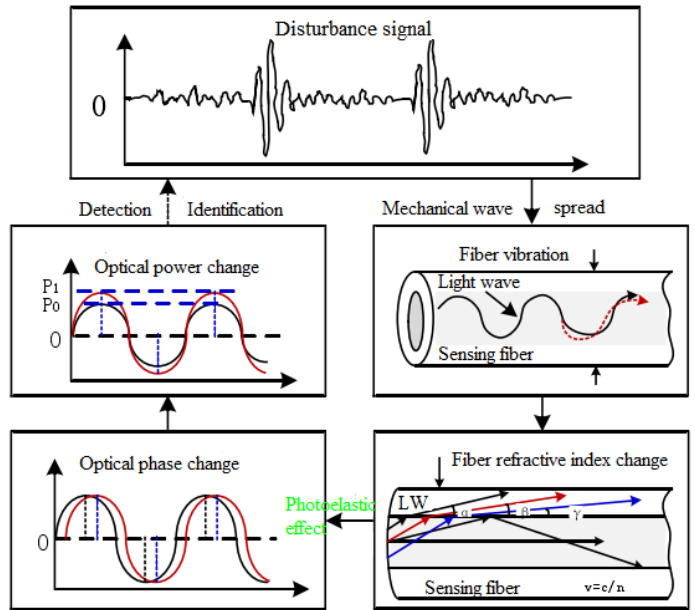
Figure 1. Principle block diagram of Sagnac optical fiber sensing detection.